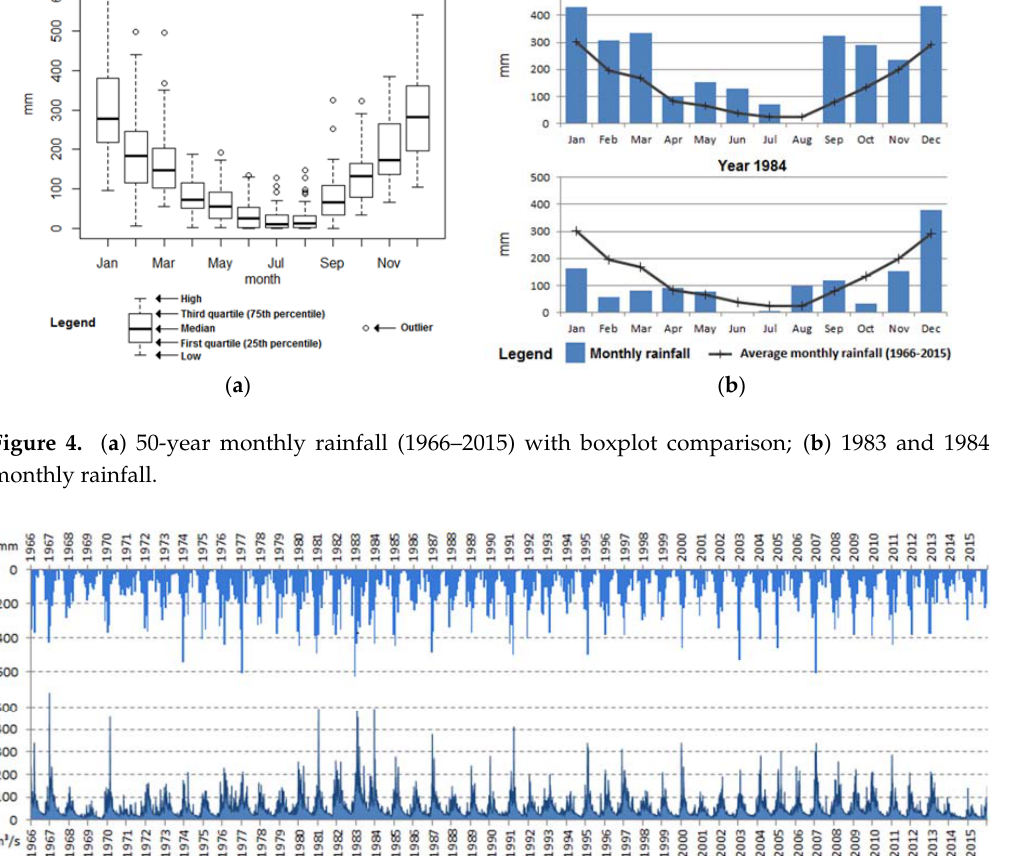
Figure 5. 50-year rainfall and natural water flow series (1966–2015) in the Caconde station.